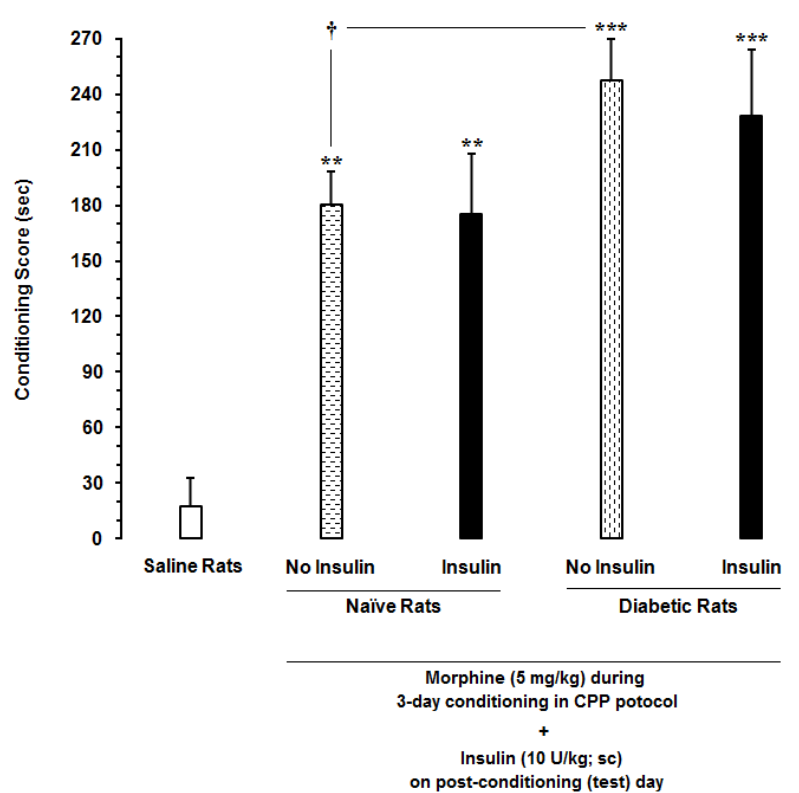
FIGURE 5 - Effect of insulin replacement on the expression of morphine-induced conditioned place preference (relevant to Figures 1D and E). Animals received insulin (10 U/kg) 30 min before starting the CPP protocol. Each point shows the mean ± SEM for 8